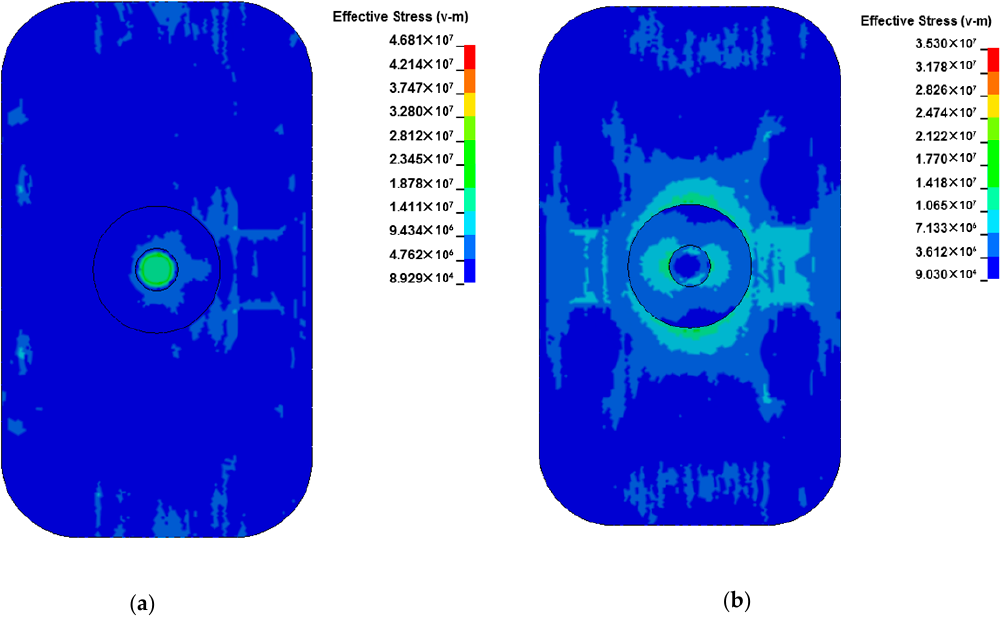
Figure 9. Stress distribution of plates. ( a ) plate stress distribution at the maximum of upper half cycle; ( b ) plate stress distribution at the maximum of lower half cycle.